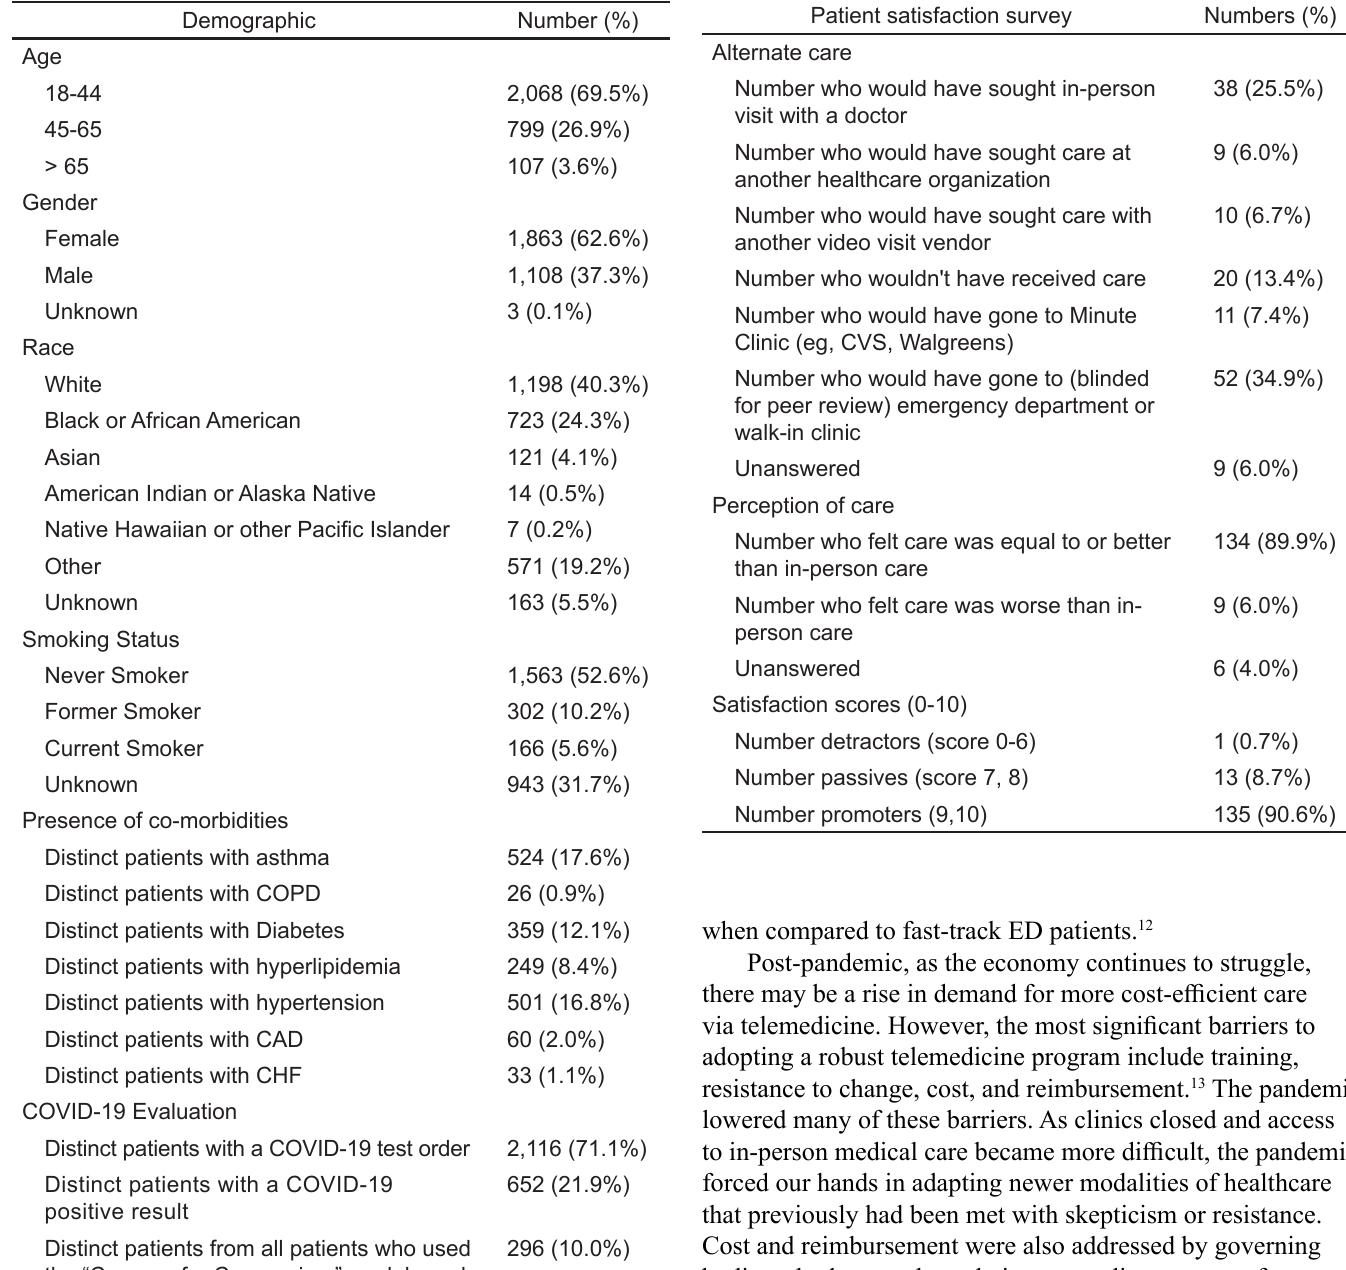
Table 1. Demographics of patients who used telemedicine. Table 2. Patient satisfaction with telemedicine